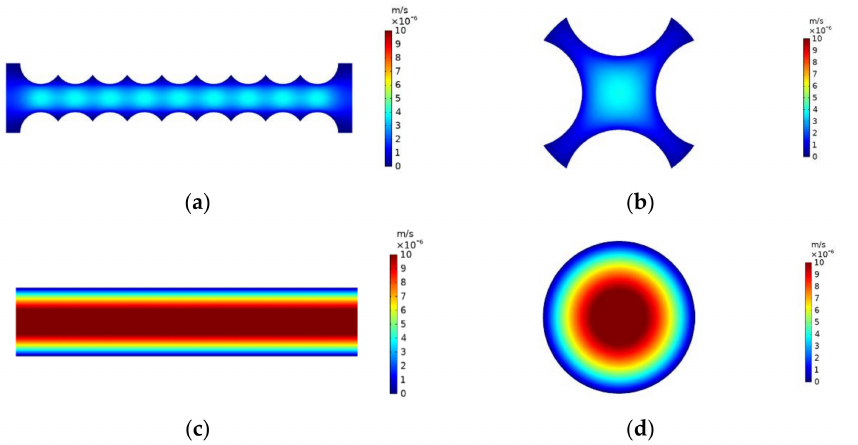
Figure 9. Velocity field distribution. ( a ) Profile of velocity (xy) in rough wall model; ( b ) profile of velocity (xz) in rough wall model; ( c ) profile of velocity (xy) in smooth wall model; ( d ) profile of velocity (xz) in smooth wall